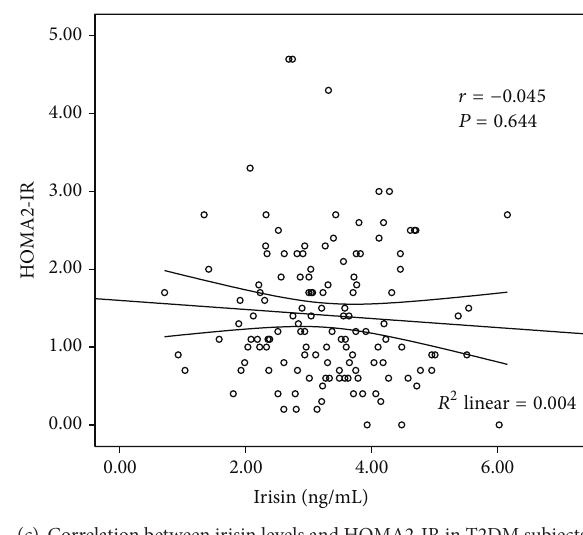
Figure 2: Correlation between irisin levels and glucose-related variables in T2DM